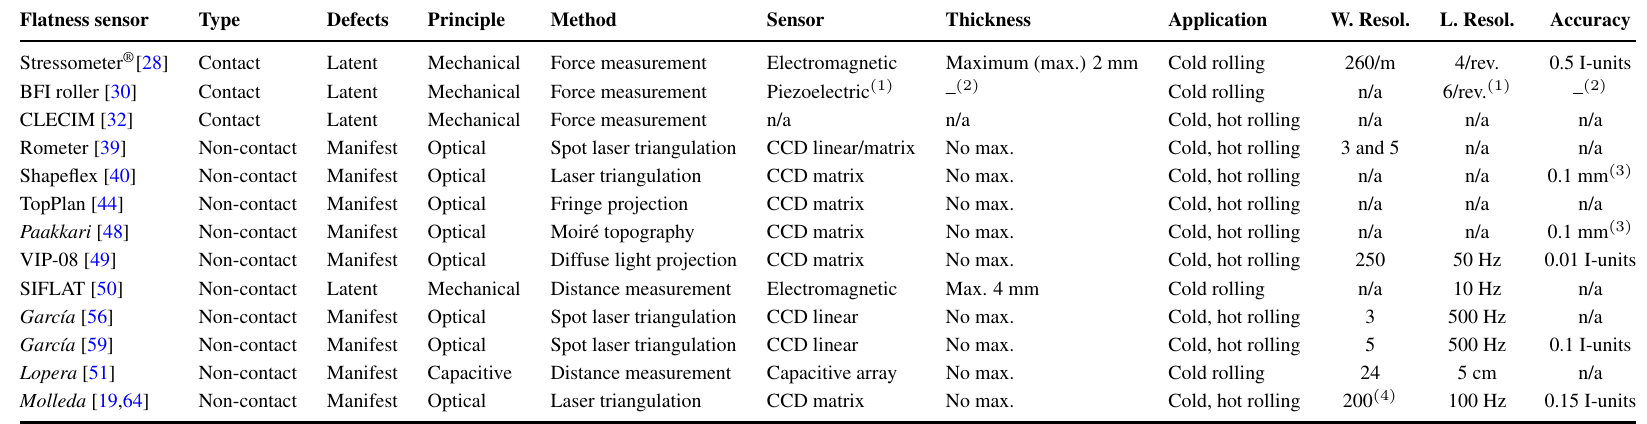
Table 1. Comparison of flatness sensors for flat-rolling or continuous production lines in the steelmaking industry. Most of these sensors can be used in other industries where rolling or continuous production lines are used, such as aluminum, copper and paper. Flatness